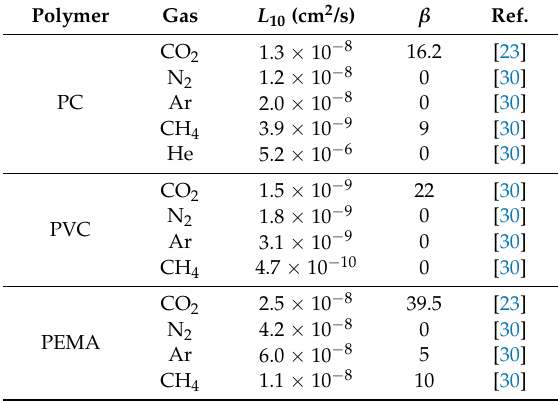
Table 3. Parameters of the STM-GP model: infinite dilution mobility coefficient L 1 0 and plasticization factor β . Polymer